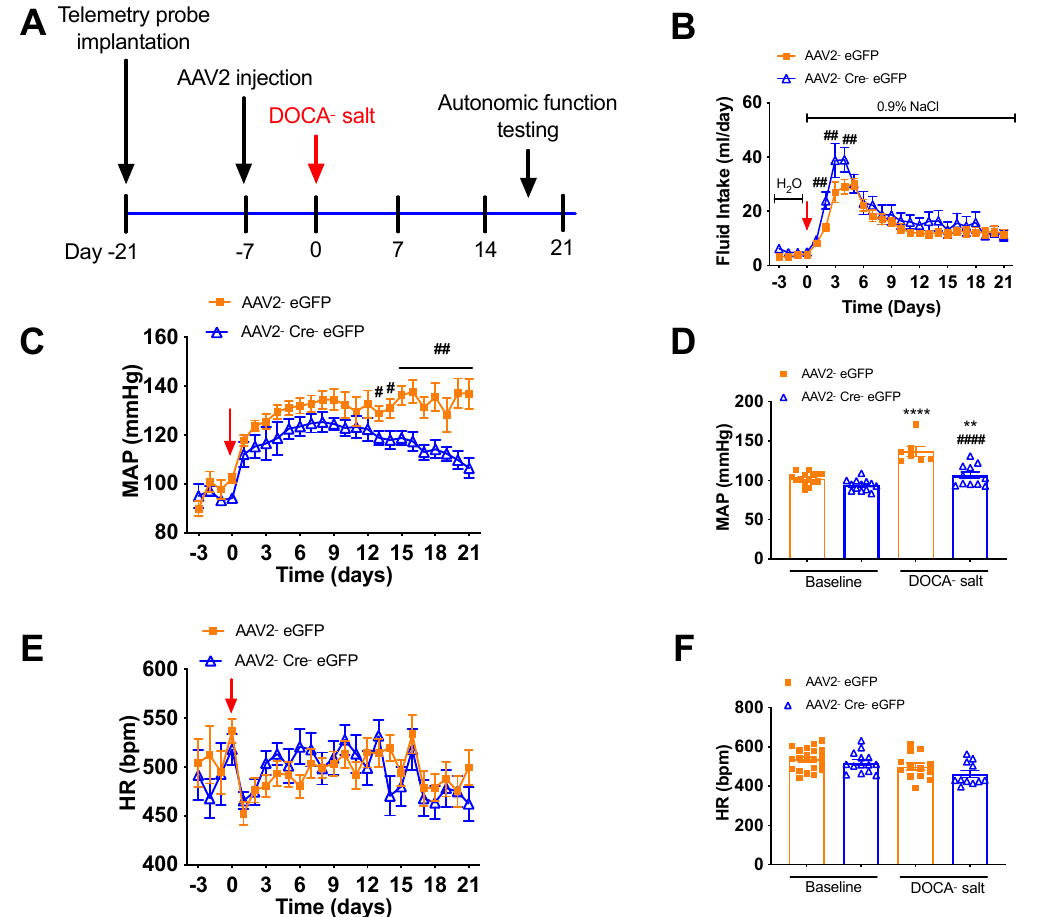
Figure 5. Renin-a deletion in the SFO attenuates DOCA-salt–induced hypertension. Renin-a–floxed mice were injected in the SFO with either AAV2-eGFP or AAV2-Cre-eGFP. BP and HR were monitored by telemetry for 3 days before and 21 days after DOCA-salt treatment. ( A ) Experimental protocol for telemetric probe implantation, virus delivery, and DOCA-salt treatment. ( B ) Fluid intake of mice before and during 21-day DOCA-salt treatment (n = 8–10 mice/group). # p < 0.05, ## p < 0.01 versus AAV2-eGFP (two-way ANOVA with mixed-effects model, Fisher’s LSD test). ( C ) Continuous mean arterial pressure (MAP) recordings before and during 21-day DOCA-salt treatment (n = 15–18 mice/group). ## p < 0.01 versus AAV2-eGFP (two-way ANOVA with mixed-effects model, Fisher’s LSD test). ( D ) Endpoint MAP at 21 days DOCA-salt treatment (n = 7–15 mice/group). ** p < 0.01, **** p < 0.0001 versus baseline AAV2-eGFP; #### p < 0.0001 versus AAV2-eGFP DOCA-salt (one-way ANOVA with Fisher’s LSD test). ( E ) Continuous HR recording before and during 21-day DOCA-salt treatment (n = 11–20 mice/group). ( F ) Endpoint HR at 21 days DOCA-salt treatment (n = 11–20